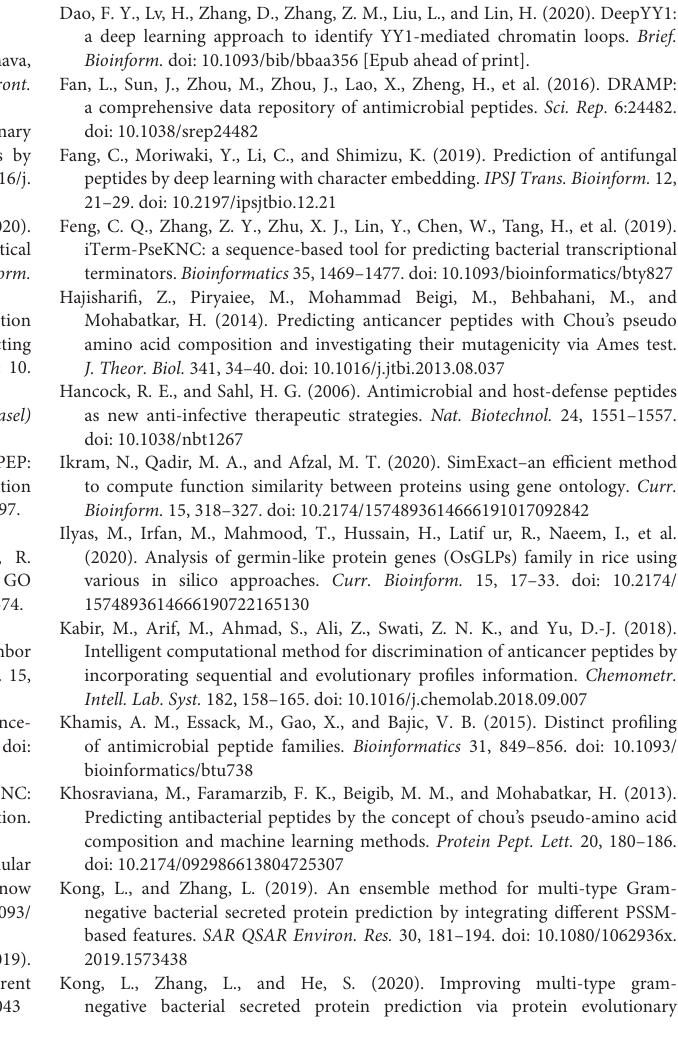
Supplementary Figure 1 | Evaluating bar chart of accuracy (ACC) values for reduced types ranging from 1 to 20 and cluster size of 2 to 19 on training dataset in DS1. The columns of corresponding reduced type and cluster size with highest ACC are marked with the highest ACC values. For example, the highest ACC value 97.21% is marked on the columns of the fifth reduced type and the 19th cluster size. Supplementary Table 1 | The hyper parameters of SVM, the best type, and the corresponding cluster size of seven different AMP functional